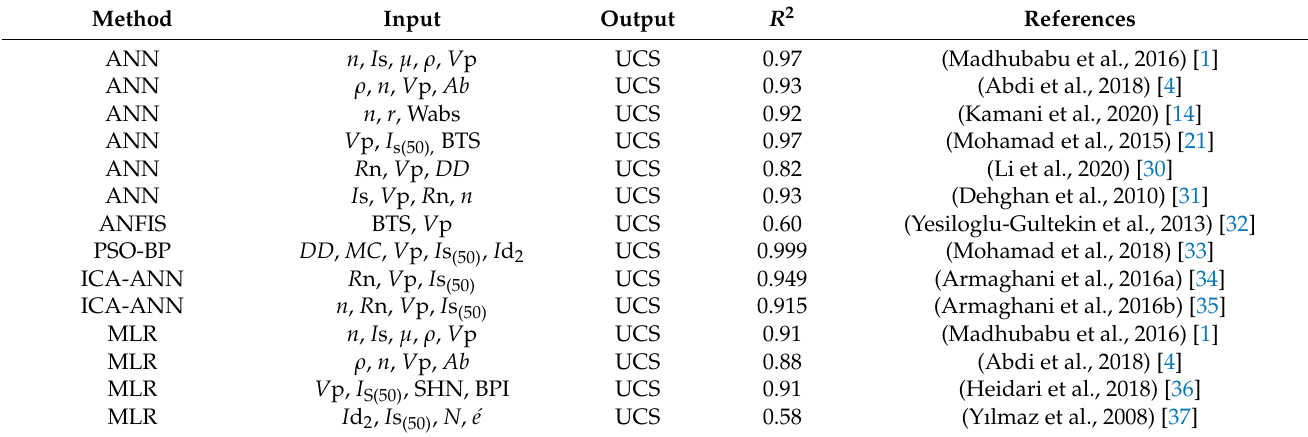
Table 1. Previous studies using intelligent methods to predict